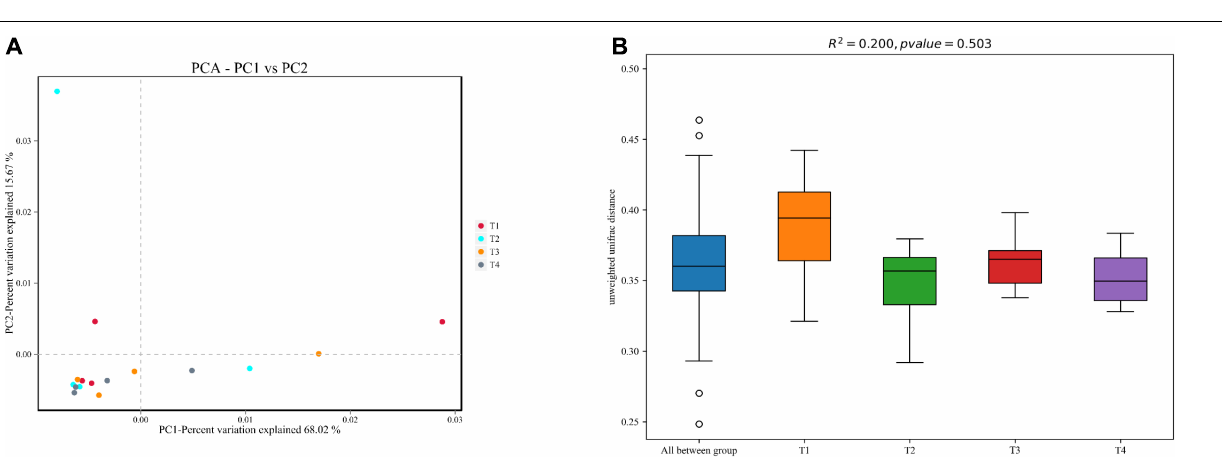
FIGURE 4 | Beta diversity of gut microbiota based on unweighted UniFrac distance of E. coioides on day 56. (A) Principal component analysis (PCA) of microbial profiles from gut of E. coioides . (B) Beta ( β )-diversity boxplots of microbial profiles from gut of E. coioides